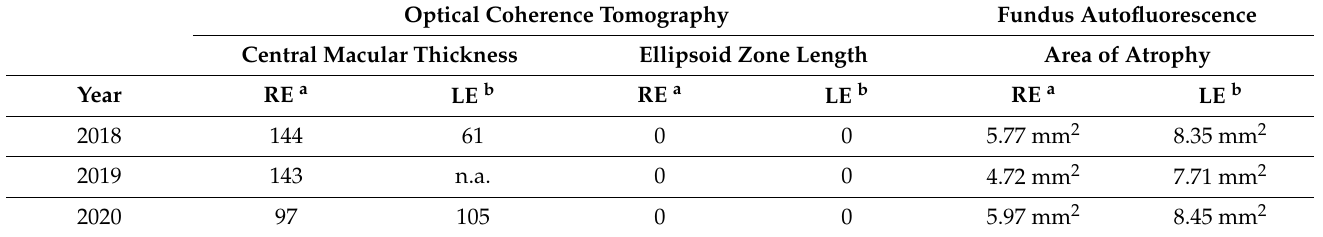
Table 1. Quantification of the evolution of the retinal pigment epithelium atrophy by optical coherence tomography (OCT) and fundus autofluorescence (FAF).